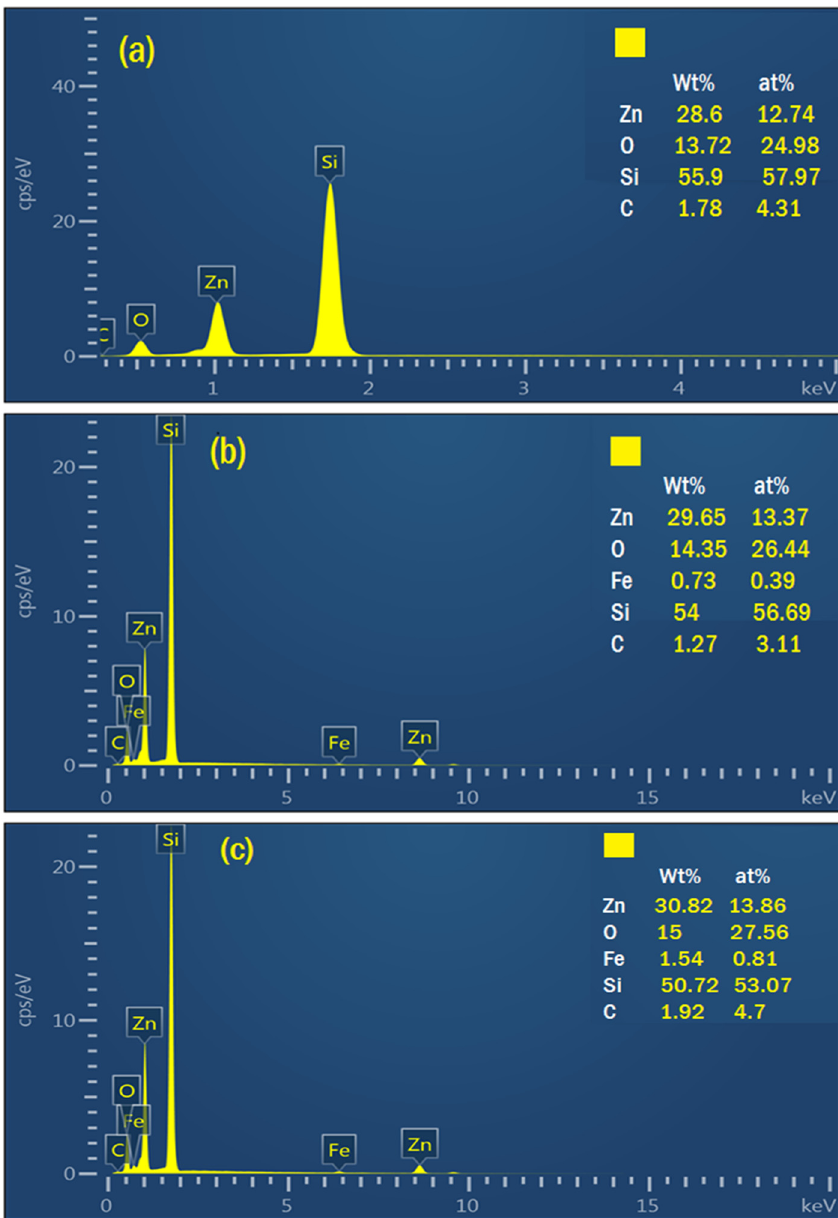
Figure 6. EDX spectrum of ( a ) undoped ZO and Fe doped ZO at DC deposited power ( b ) 3 W and ( c ) 10 W.